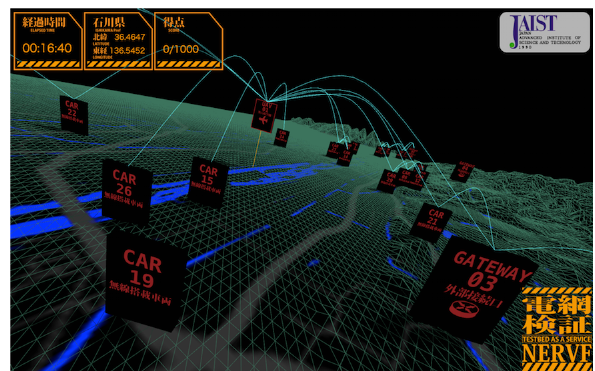
Figure 4: Overview of the demonstration